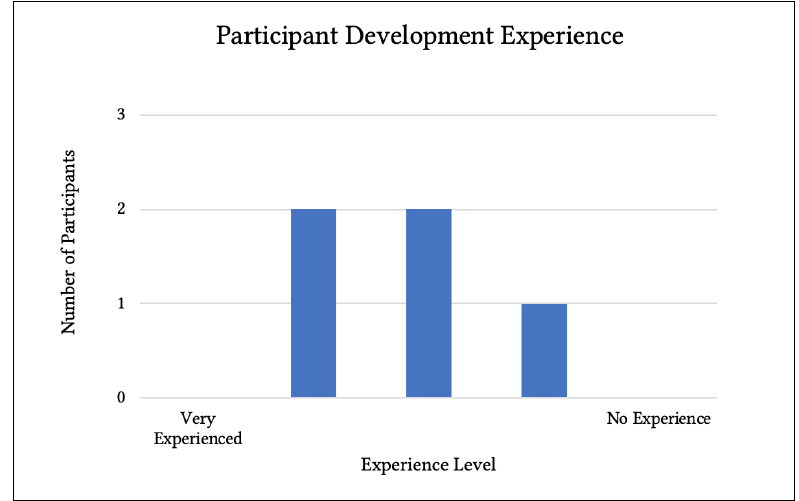
Figure 8. Development experience of